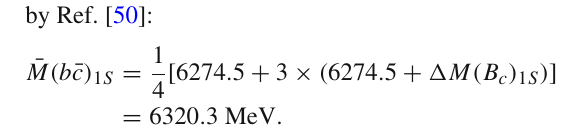
For the B c meson, no data in P wave is available. We estimate it via interpolating the P wave masses of the c ¯ c ¯ b systems which are known experimentally. and b